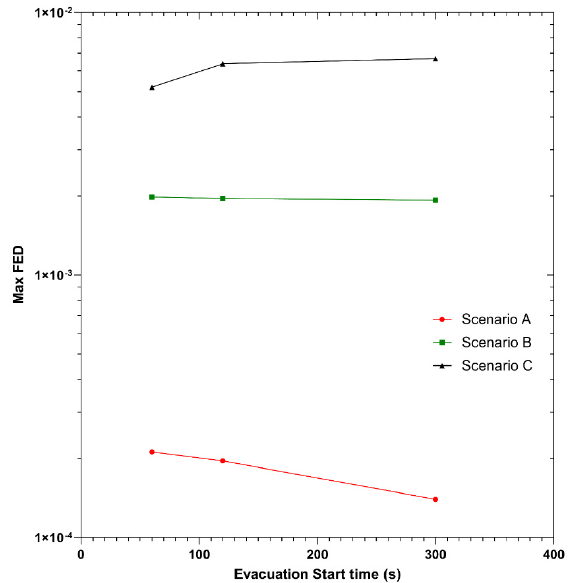
Figure 14. Max FED index for the three different scenarios and evacuation Figure 15. Max FED index for the three different scenarios and evacuation times. Table 2. Mean FED index for the three different scenarios and evacuation times.